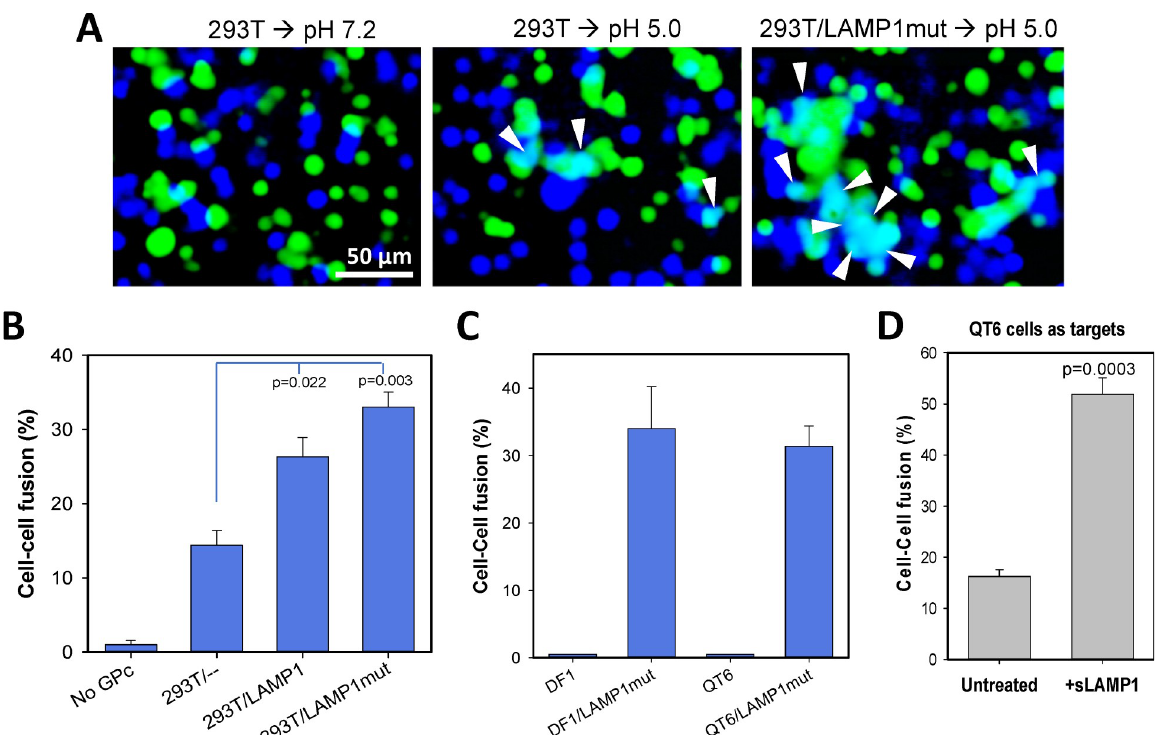
Fig 2. LAMP1-dependence of LASV GPC-mediated cell-cell fusion. (A) Representative images of effector COS7 cells transfected with LASV GPC and loaded with calcein-AM (green) and target HEK293T cells loaded with CMAC cytoplasmic dye (blue). HEK293T cells were transfected with the LAMP1 D384 mutant (LAMP1mut, right panel) or mock-transfected. Effector and target cells were mixed, allowed to adhere to poly- lysine-coated chambered slides and incubated for 30 min at room temperature. Fusion was triggered by exposing cells to a pH 5.0 buffer for 20 min at 37˚C. Control wells were exposed to a pH 7.2 buffer (left panel). Double-positive fusion products are indicated by arrowheads. Scale bar 50 μ m. (B) LAMP1-dependence of fusion between LASV GPC-expressing COS7 cells (loaded with calcein-AM) and HEK293T cells (loaded with CMAC) transfected with wild-type human LAMP1, LAMP1mut or mock-transfected. As a negative control, fusion between untransfected COS7 cells with HEK293T cells was measured. A 1:1 mixture of effector and target cells was adhered to poly-lysine coated coverslips and incubated 30 min at room temperature. Cell fusion was triggered by exposure to pH 6.2 for 10 min at room temperature (suboptimal trigger), and the fraction of cells positive for both cytoplasmic markers was measured after an additional incubation for 1 h at 37˚C, neutral pH. The results are means and SEM from three independent experiments. (C) LAMP1-dependence of GPC-mediated fusion with avian DF-1 and QT6 cells. Avian cells transfected or not transfected with the human LAMP1mut were brought in contact with LASV GPC-expressing COS7 cells and exposed to pH 5.0 for 10 min at room temperature. The results are means and SEM from three independent experiments. (D) Soluble LAMP1 (sLAMP1) enhances GPC-mediated fusion with QT6 cells. GPC-expressing COS7 cells were co-plated with QT6 cells on coverslips for 30 min at room temperature to allow attachment and cell-cell contacts. The cells were further incubated in the absence or in the presence of 0.05 μ g/ml of sLAMP1 for 20 min at room temperature, and fusion was triggered under optimal conditions (pH 5.0 at 37˚C, 20 min). The results are means and SEM from three independent